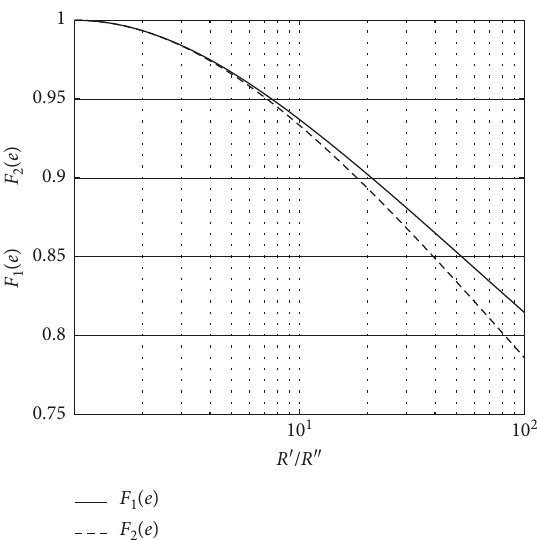
1 ( e ) and ( F ) 2 ( e ) versus ratio of